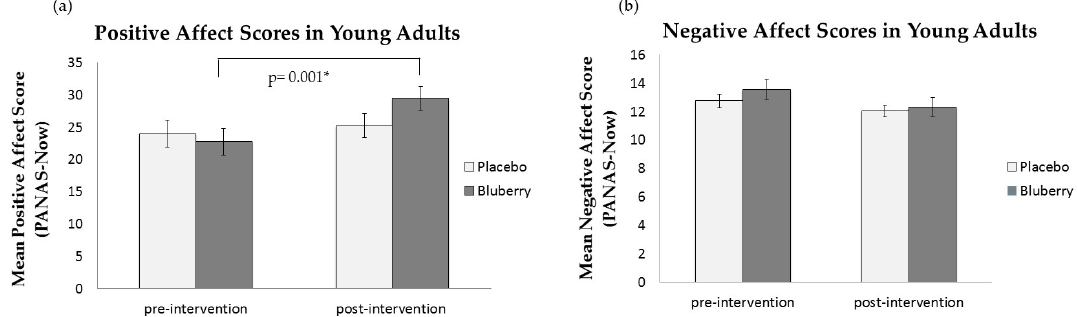
Figure 1. Mean PANAS ‐ NOW Mood scores in adults aged 18–21 years: ( a ) Mean PA scores pre ‐ and post ‐ consumption of placebo and WBB drinks; ( b ) Mean NA scores pre ‐ and post ‐ consumption of post-consumption of placebo and WBB drinks; ( b ) Mean NA scores pre- and post-consumption of placebo and WBB drinks. placebo and WBB